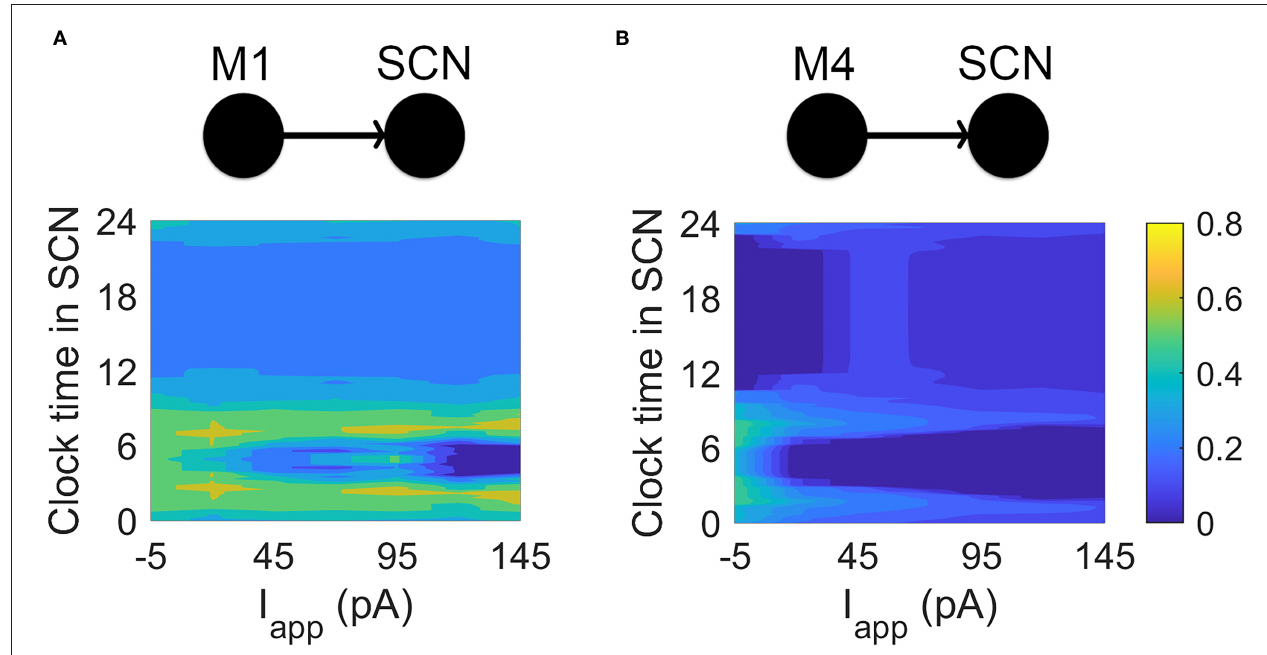
FIGURE 4 | Simulating connections between M1, M4, and SCN cells. (A) Current-clamp data from M1 cells is passed via model glutamate synapses to a simulated SCN cell. While SCN neurons are able to match the firing rates of M1 cells, they are unable to match the firing rates of M4 cells. The heat maps show the ratio (output SCN firing rate)/(input ipRGC firing rate) at different times of the circadian day and for different applied currents. For the M1-SCN connection, several input currents and clock times are able to achieve near 1:1 input firing rate:output firing rate (yellow in the heat map). (B) Current-clamp data from M4 cells is passed via a simulated— and non-physiological—glutamate synaptic model to a simulated SCN cell. SCN cells are unable to match the firing rates of the M4 cells, as seen in the heat map, which again shows the ratio (output SCN firing rate)/(input ipRGC firing rate) at different circadian times and for different applied currents. For the M4-SCN connection, the SCN at best captures one fifth of the action potentials sent by the M4 cell.